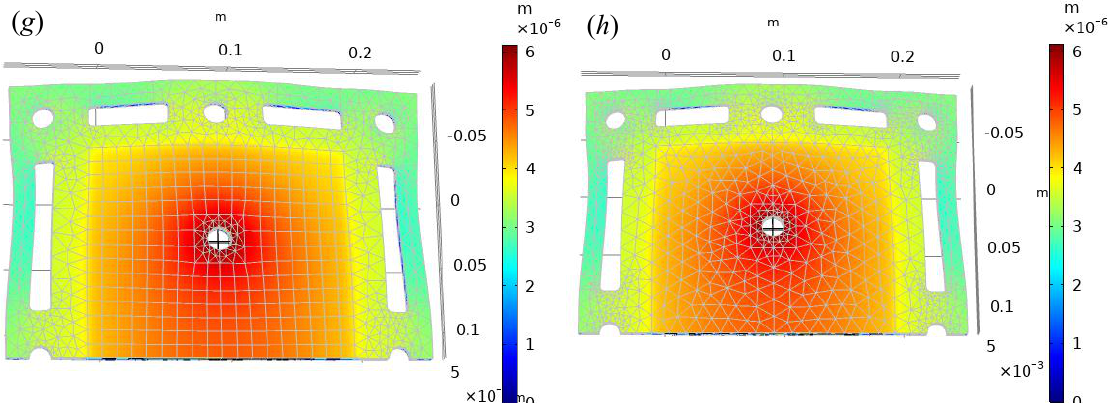
Figure 6. The comparison between the numerical solution of the thermo-mechanical coupling model of the hybrid finite element corresponding to the bipolar fuel cell plate and the adaptive FEM. ( a ) Hybrid-element grid quality assessment results. ( b ) Adaptive FEM grid quality assessment results. ( c ) Von Mises stress diagram of hybrid finite element. ( d ) Von Mises stress diagram solved using adaptive FEM. ( e ) Temperature T nephogram of hybrid finite element. ( f ) Temperature T numerical solution nephogram solved using adaptive FEM. ( g ) Displacement nephogram W h . ( h )